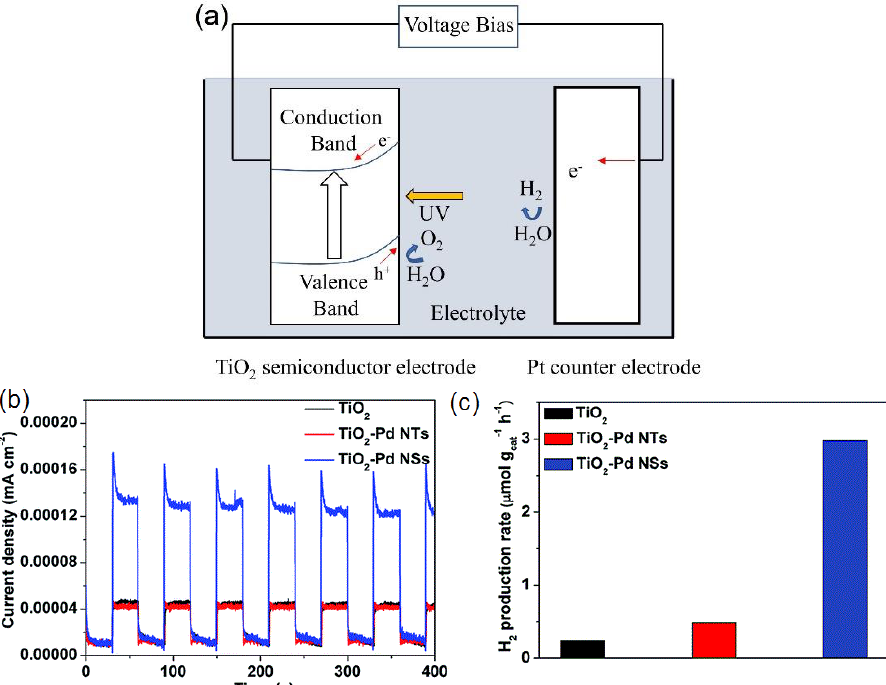
Figure 24. (Top, ( a )) Schematic of the water splitting system using a wide bandgap TiO 2 semiconductor photoelectrode and a Pt counter electrode demonstrated by Fujishima and Honda in their landmark work in 1972. Adapted with permission from Ref [50] Copyright Nature Publishing Group (1972). (Bottom, ( b )) Photocurrent measurements made on TiO 2 –Pd nanosheet and nanotetrahedron samples and compared to that of bare TiO 2 samples. The higher photocurrent of TiO 2 –Pd nanosheets confirms plasmonic hot electron injection, while there is not too much difference in photocurrent magnitudes between bare TiO 2 and TiO 2 –Pd nanotetrahedrons. This provides evidence of the poor hot electron injection abilities of Pd nanotetrahedrons as compared to Pd nanosheets. ( c ) Hydrogen production rates under vis-NIR light irradiation are shown, and as can be seen the TiO 2 –Pd nanosheets exhibit photocatalytic hydrogen evolution activity unlike bare TiO 2 and TiO 2 –Pd nanotetrahedrons [271]. These experiments provide simple insights on the application of hot electrons in photoelectrochemical water splitting. Reprinted with permission from Ref [271] Copyright Royal Society of Chemistry